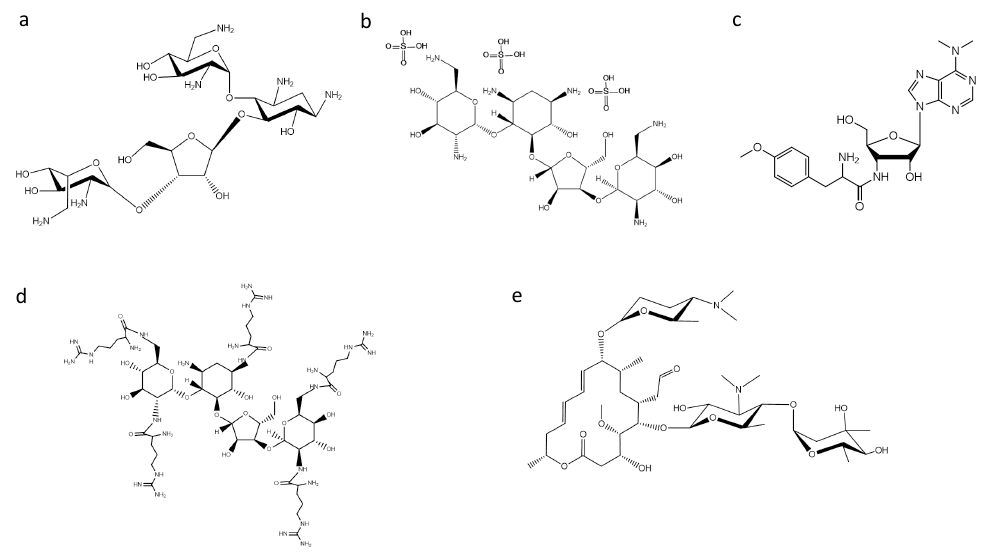
Figure 1. Structures of: ( a ) neomycin B; ( b ) neomycin sulfate; ( c ) puromycin; ( d ) aminoglycoside derivative NeoR5; and ( e ) spiramycin.